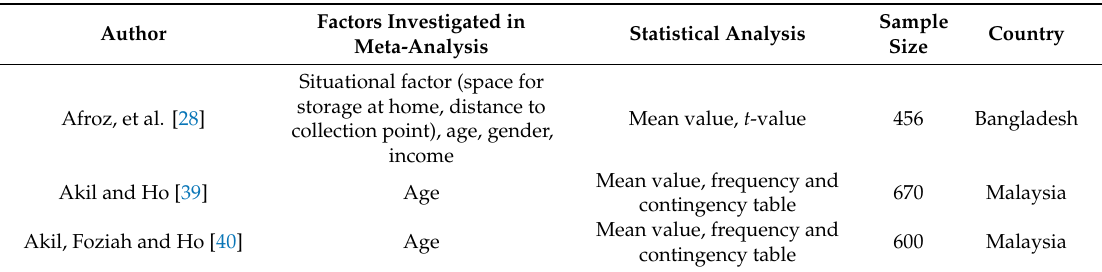
Table A1. Authors: influencing factors on household waste sorting, statistical analysis and sample sizes and countries studied